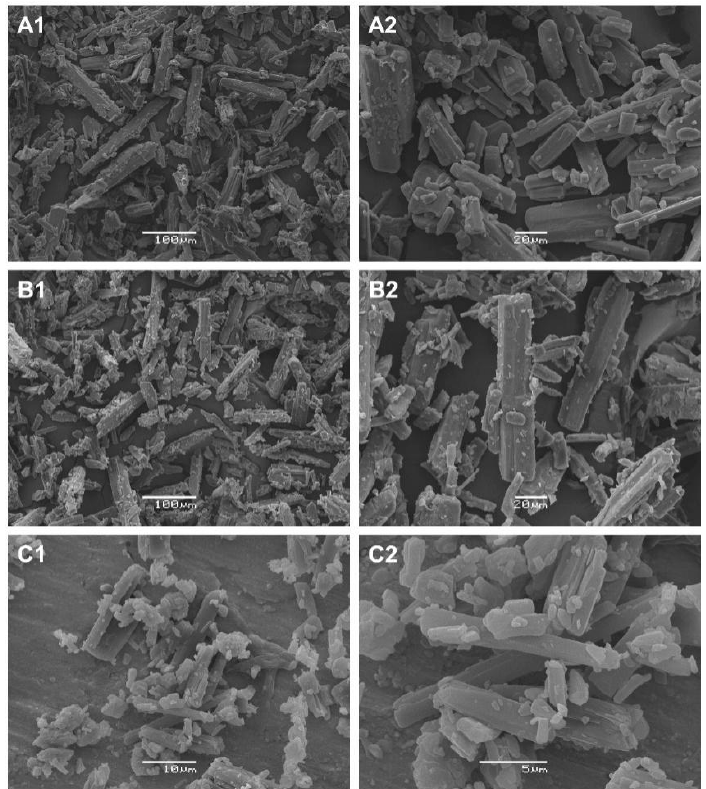
Figure 14. Photomicrographs obtained by scanning electron microscopy (SEM): STG ( A1 and A2 ; 200× and 600×), STGA ( B1 and B2 ; 200× and 600×) and STGB ( C1 and C2 ; 2000× and 5000×).